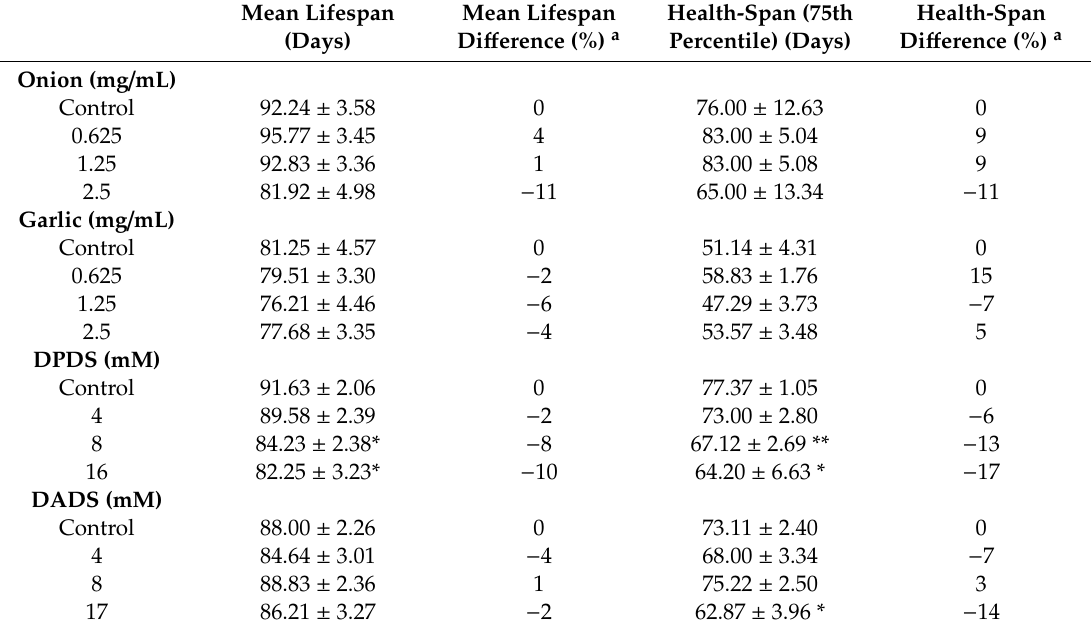
Figure 2. E ff ects of garlic, onion, DADS, and DPDS supplementation on the lifespan of Drosophila melanogaster . Table 2. E ff ects of the tested compounds at di ff erent concentrations on the Drosophila melanogaster mean lifespan and health